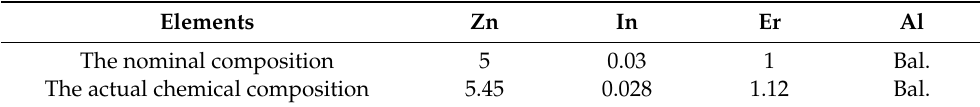
Table 1. The chemical composition of the experimental alloy (mass fraction, wt.%).